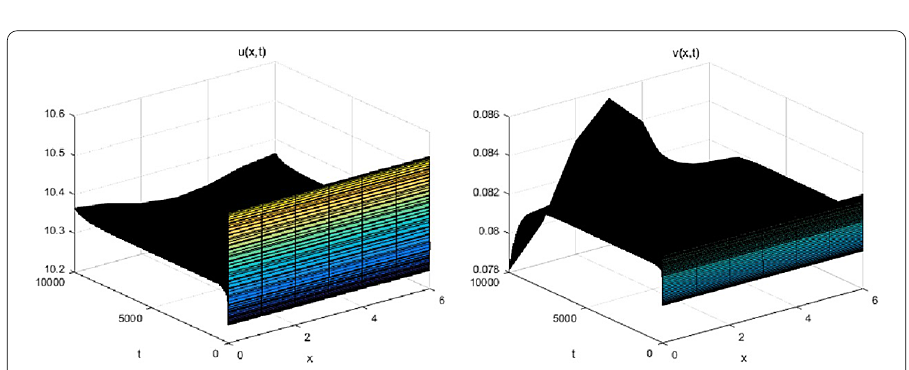
Figure 3 The numerical simulations of system (1.4) with parameters in (4.1) and d 1 = 2, d 2 = 0.001, r 1 = 0.2. Left: component u has Turing instability. Right: component v has Turing instability